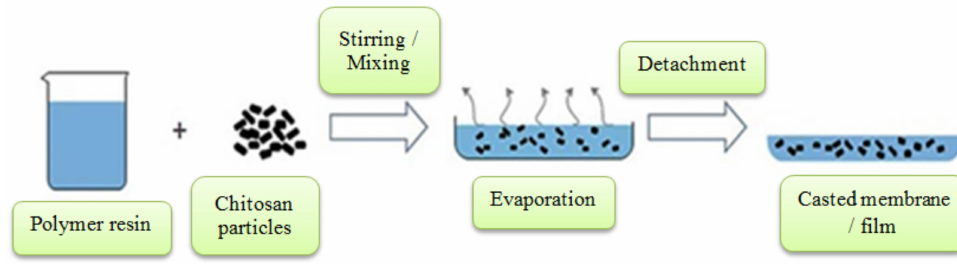
Figure 5. Solvent casting for film and membrane manufacture.